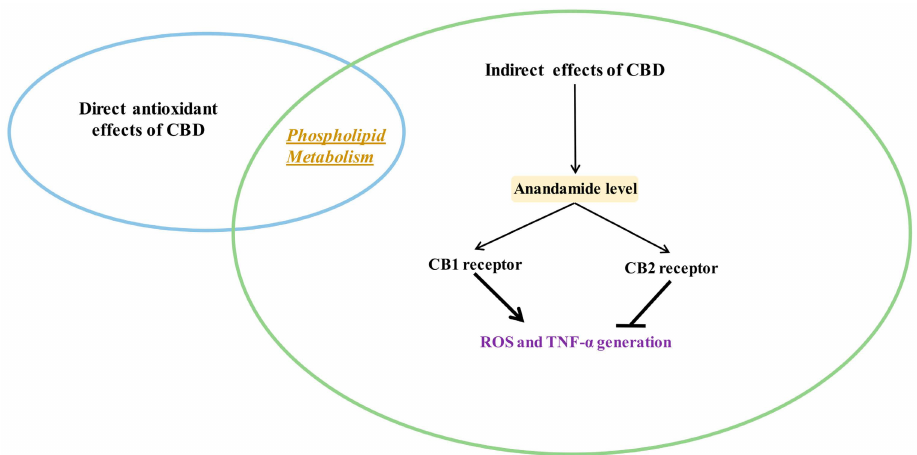
Figure 3. Indirect antioxidant and anti-inflammatory e ff ects of CBD (closed arrows indicate inhibition; opened arrows indicate